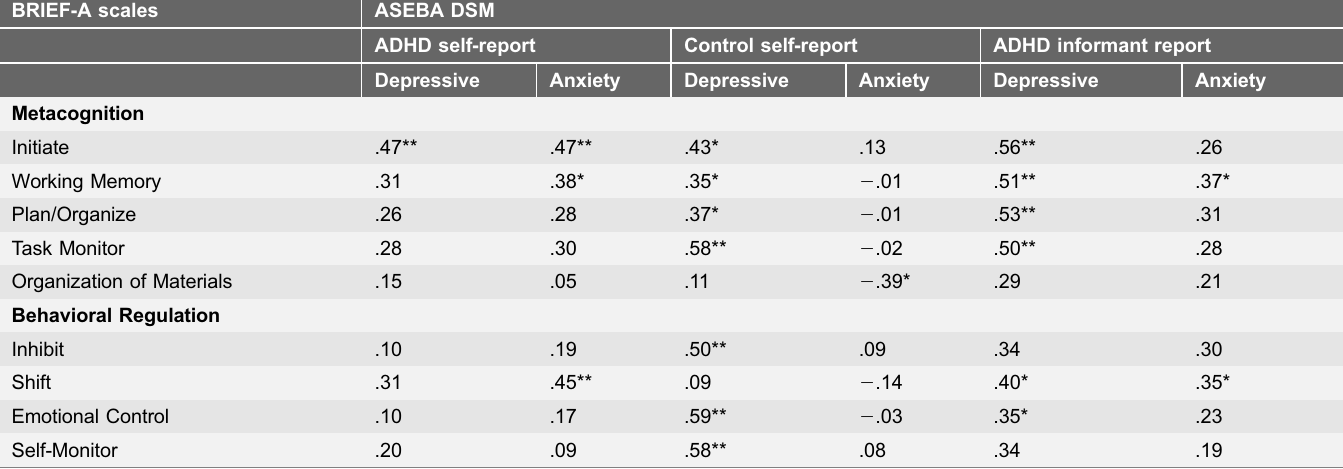
Table 5. Correlations between ASEBA and BRIEF-A self-report for the ADHD group and the healthy control group, and between the ADHD patients’ ASEBA and BRIEF-A informant-report. BRIEF-A scales ASEBA